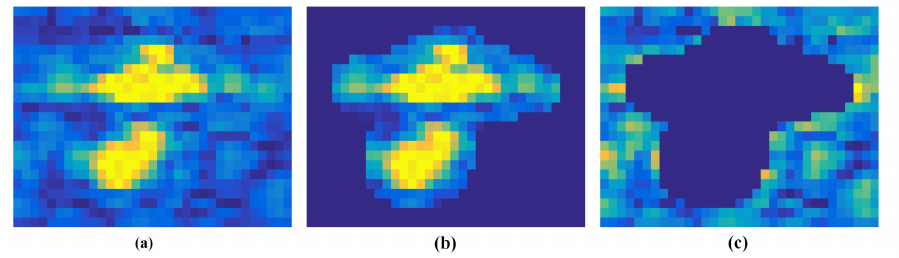
Figure 4. Separation of the target to be detected from the background. ( a ) Target and background to be detected; ( b ) Target to be detected; ( c ) Background to be detected.